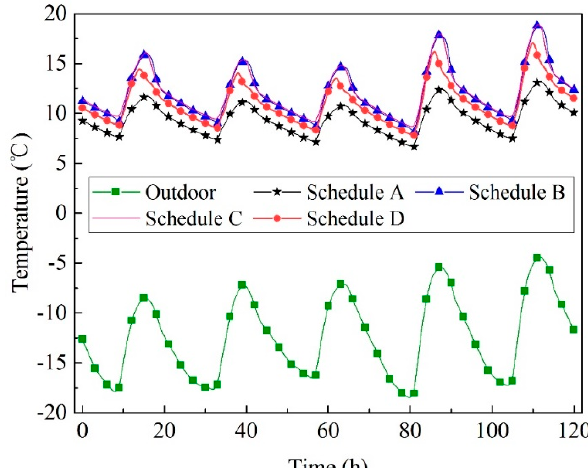
Figure 13. Air temperatures under diverse window schedules.